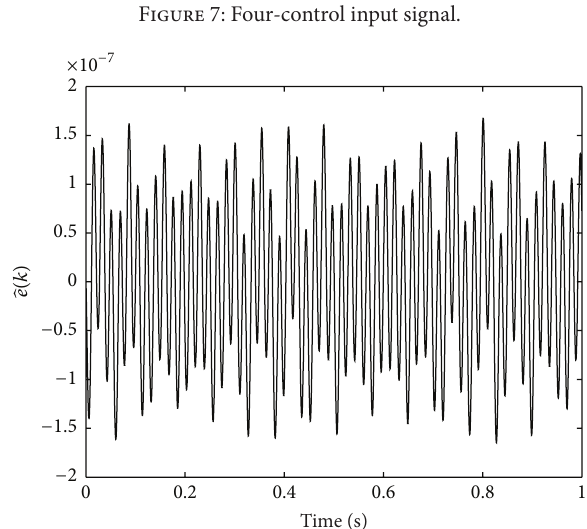
Figure 8: Output estimation error with